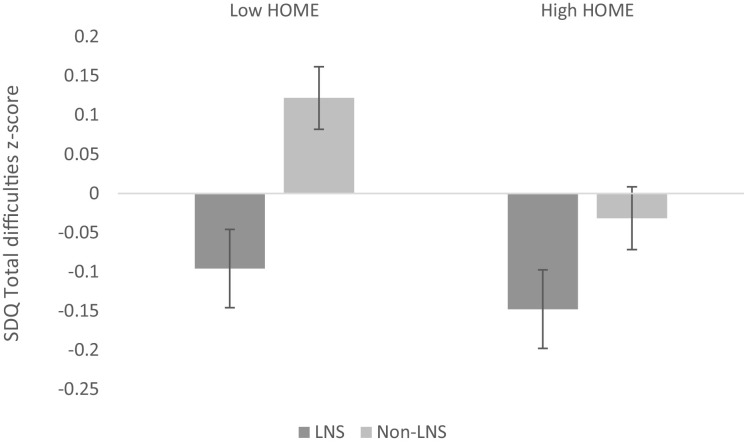
Mean social-emotional difficulties score by intervention group and HOME score. Error bars show the standard error of the mean. High HOME, HOME score above the sample median; HOME, Home Observation for the Measurement of the Environment Inventory; LNS, lipid-based nutrient supplement for mothers and children; Low HOME, HOME score below the sample median; Non-LNS, iron and folic acid or multiple micronutrient capsules for mothers only (control group). P for interaction between HOME score (categorized by the median population score as low HOME or high HOME score) and intervention group = 0.081.